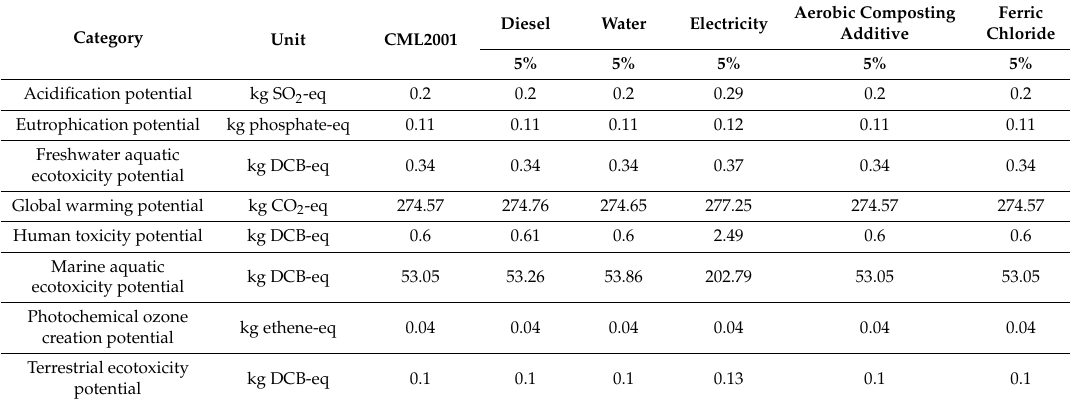
Table 6. Sensitivity analysis of key